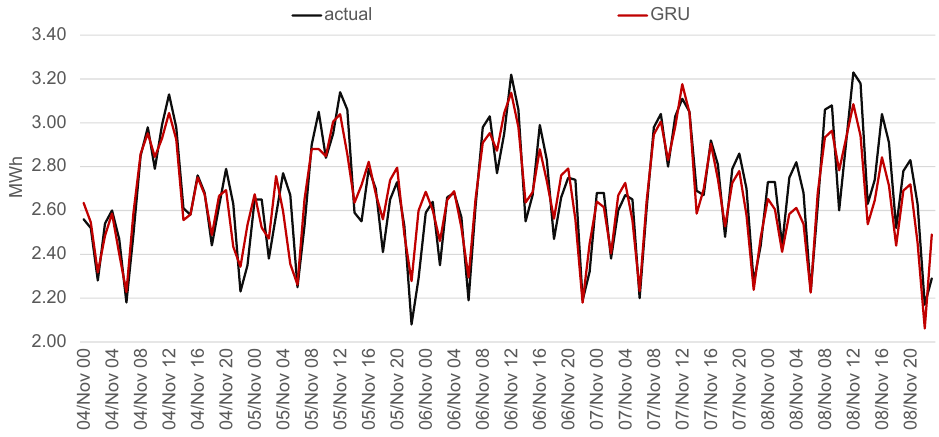
the training stage. Building larger and training for more epochs did not improve the errors and the network failed due to overfitting on the training data.